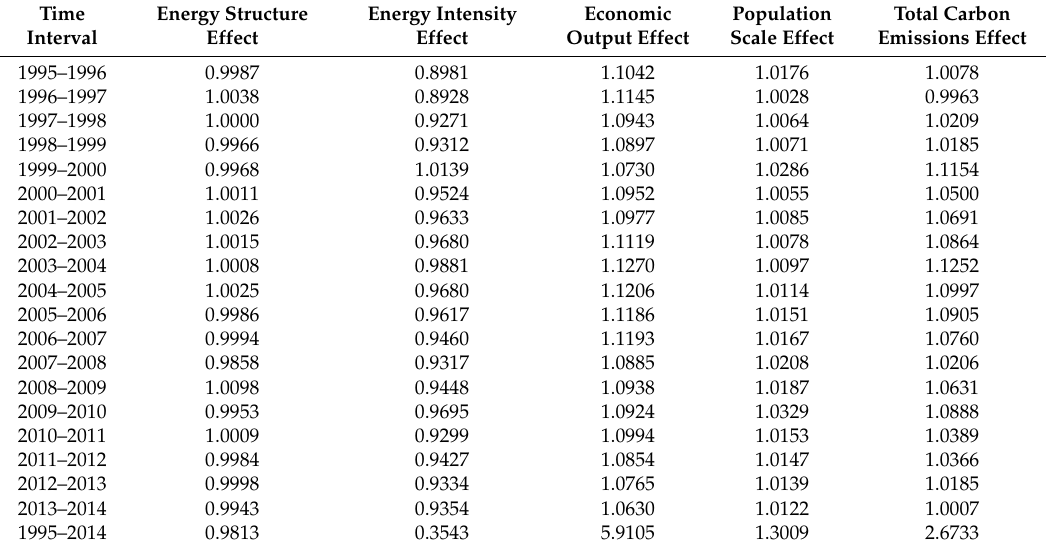
EEX /  ii 2 denotes the refers to the refers